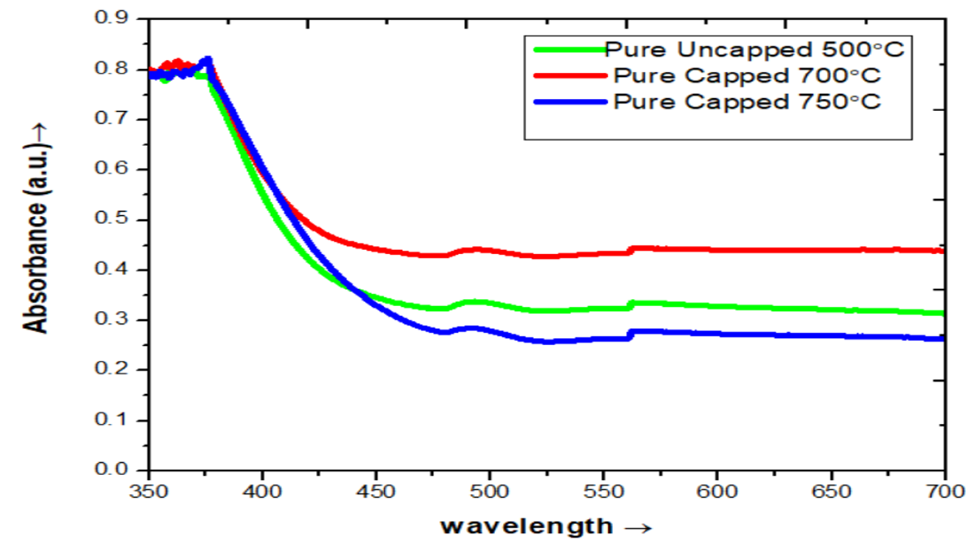
Figure 1. UV-vis. absorption spectrum of pure and capped ZnO nanopowder with different temperatures.